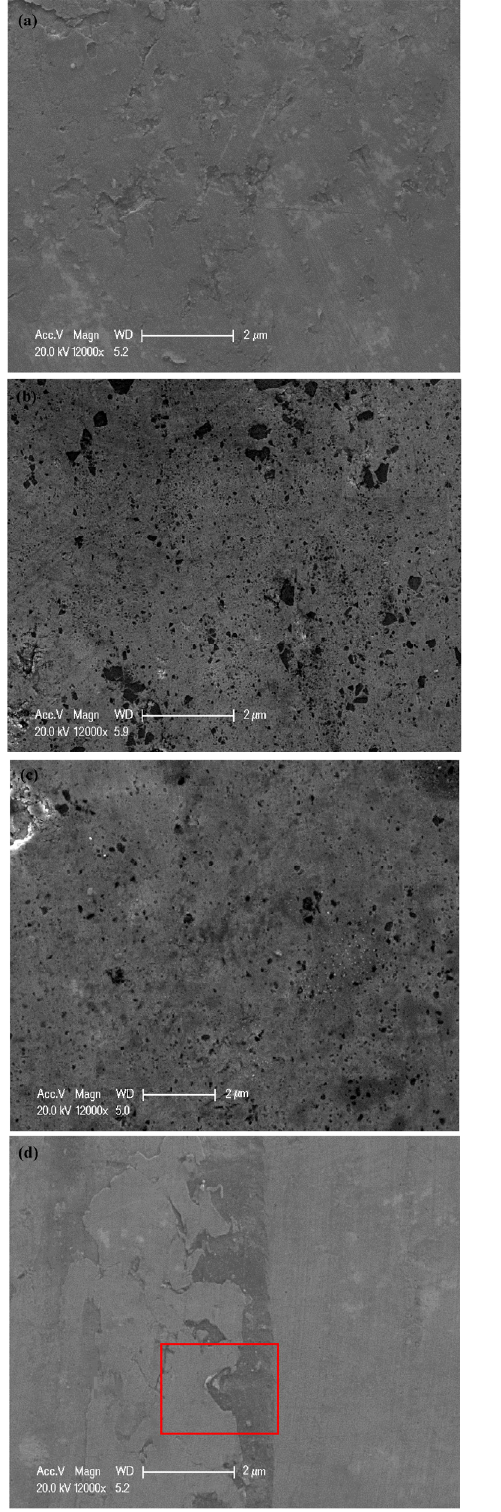
Fig. 13 SEM photograph of the worn surface morphology of Cu (a and d), Cu-10 (b and e), and 20%SiC (c and f) HPTed samples corresponding to a sliding distance of 2,500 m and applied loads of 5 N (a–c) and 30 N (d–f), and (g–h) the corresponding WC wear surface morphology after the sliding against Cu-20%SiC HPTed sample under sliding distance of 2,500 m and an applied load of 30 N under different